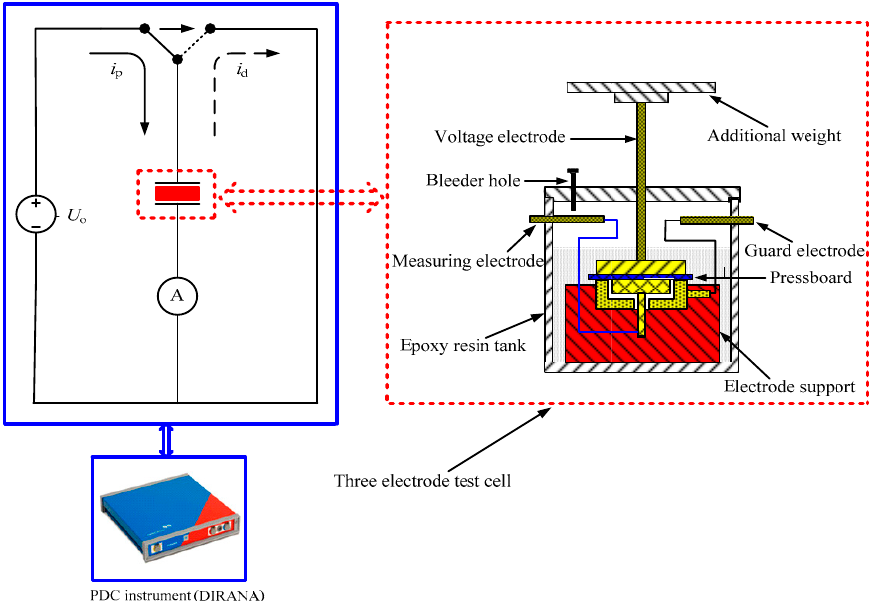
Figure 2. Graphic diagram of the assembly used for the polarization and depolarization current (PDC) measurements with DIRANA.